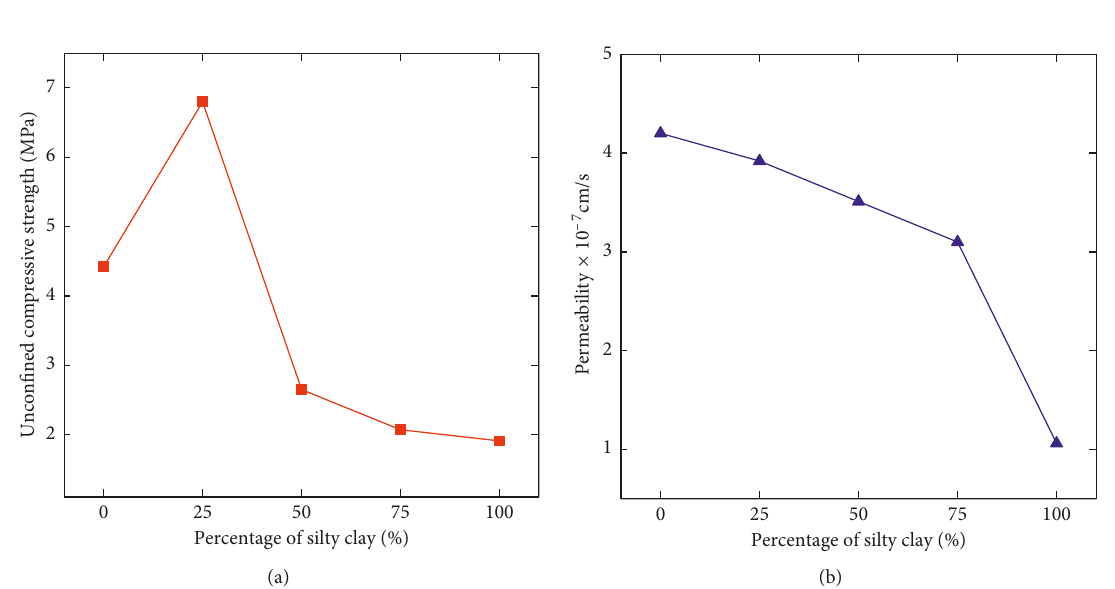
Figure 6: Results of fine sand and silty clay mixed-soil cement: (a) unconfined compressive strength; (b) permeability